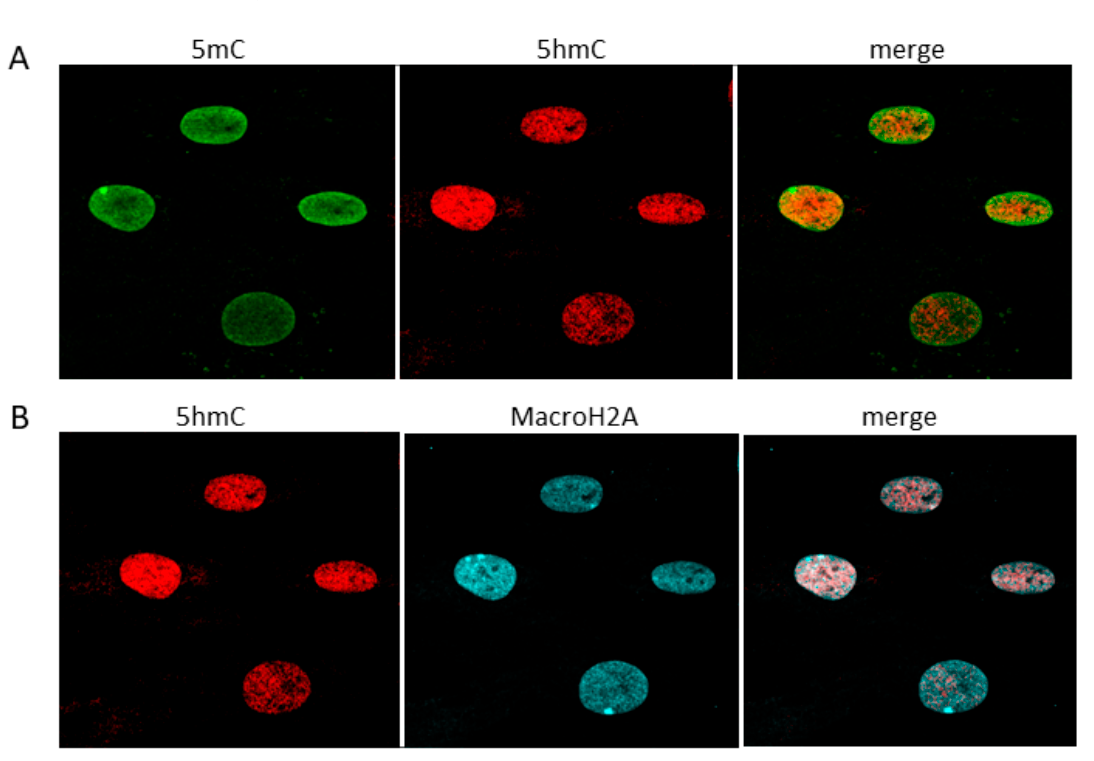
Figure 3. Immunofluorescence staining for the presence of 5-methylcytosine (5mC), 5-hydroxymethylcytosine (5hmC), and heterochromatin markers in human fibroblasts. ( A ). Immunostaining for the presence of 5mC and 5hmC. ( B ). Co- localization of 5hmC and MacroH2A histone variant. ( C ). Co-localization of 5hmC and heterochromatin protein 1 (HP1). 2.2. Age-Related Differential 5-Hydroxymethylation in Fibroblasts The lack of age-related differences in the quantity of global 5hmC does not exclude age-related changes in 5hmC distribution. Therefore, using two different algorithms but with the same set of DNA window sizes (wide, approximately 450 bp and narrow, approximately 50 bp) and statistical methods, we searched for age-related differentially hydroxymethylated regions (DHMRs) in DNA isolated from fibroblasts of five young and five older individuals. A DiffBind analysis performed for the wide window identified 190 DHMRs, including 102 that were hyper- and 88 that were hypo-hydroxymethylated, while the analysis of the narrow window identified 186 DHMRs, including 97 hyper- and 89 hypo- hydroxymethylated (Figure 4, Supplementary Table S1). Eighty-five regions were common to both windows. The MEDIPS analysis of the wide window identified 161 DHMRs, including 83 hyper- and 78 hypo-hydroxymethylated, and the analysis of the narrow window identified 228 DHMRs, including 121 hyper- and 107 hypo-